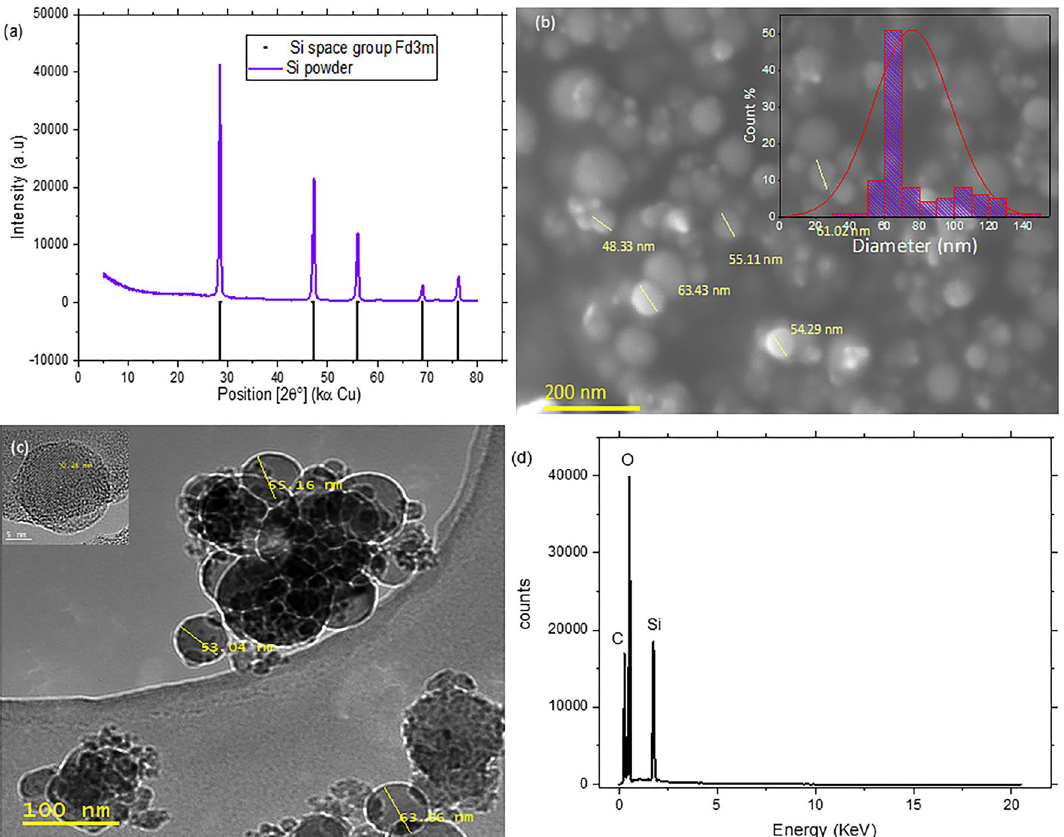
Figure 1. Structure, particle size/morphology and composition for the silicon ( a ) XRD pattern measured using Cu radiation, ( b ) a SEM image and histogram inset showing particle size distribution, ( c ) a TEM image and ( d ) EDX